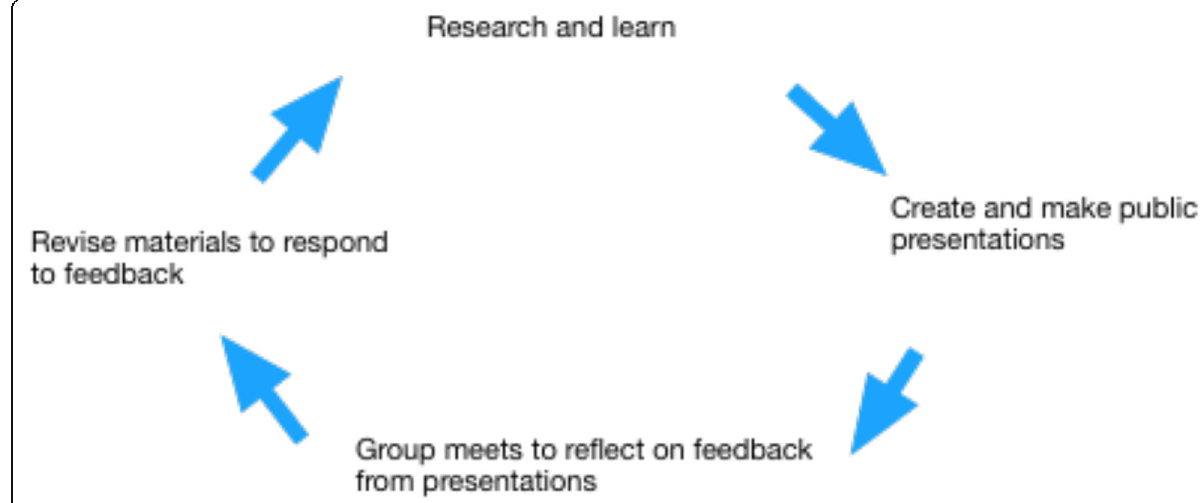
Fig. 2 The students ’ iterative learning